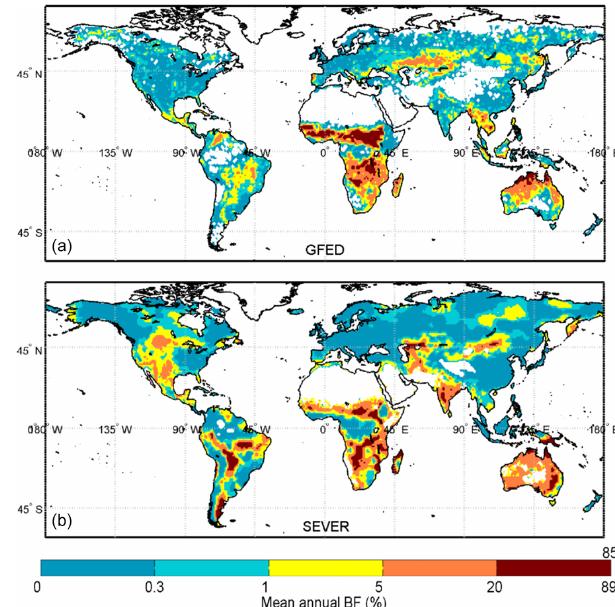
Figure 5. Mean annual burned fraction (percentage) over 1997– 2006. (a) GFED; (b)